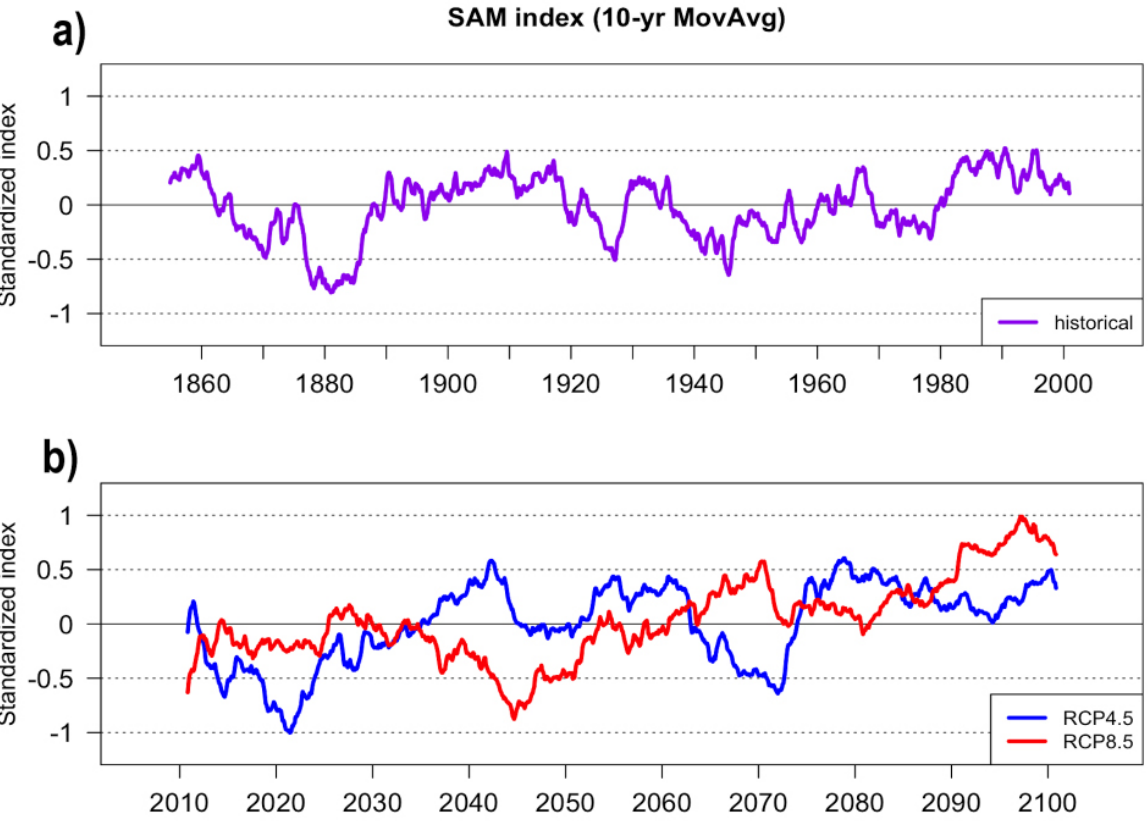
Figure 2. GW99 10-yr moving average of SAM index in BESM-OA2.5: a) Historical (purple line); b) RCP4.5 (blue line), and RCP8.5 (red